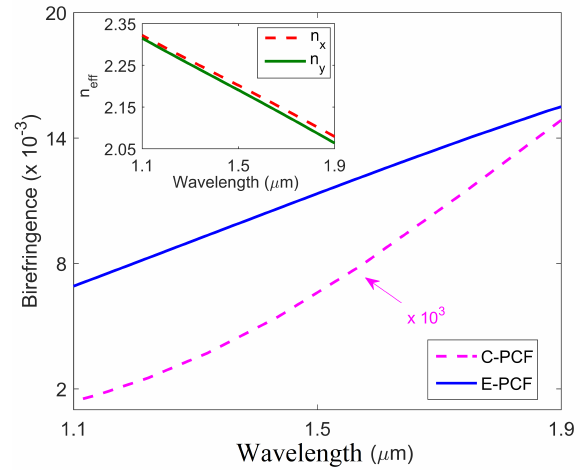
Figure 7. Birefringence of C-PCF with circular-core and elliptical-core as a function of wavelength. The C-PCF parameters are: d / Λ = 0.692, d c / Λ = 0.876, Λ = 0.867 µ m, and E-PCF parameters are b / a = 0.75 and a = 1 µ m. The inset show effective modal indices of fundamental guided mode of E-PCF for x-polarized and y-polarized light. Note that the birefringence of circular-core PCF is enhanced by three orders of magnitude to facilitate